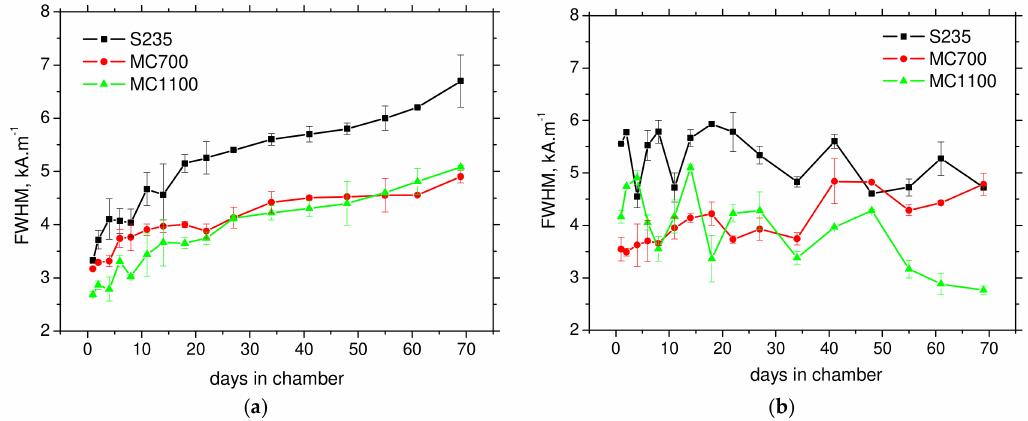
Figure 9. Evolution of FWHM along the days in the chamber. ( a ) RD, ( b )